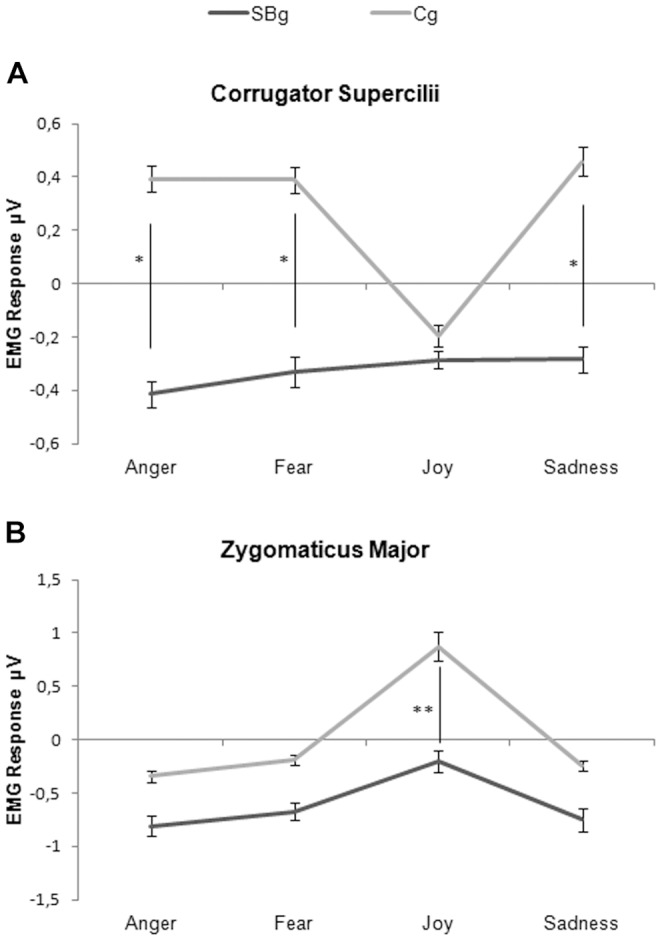
EMG responses.Corrugator Supercilii (A) and Zygomaticus Major (B) EMG responses for Street-Boys group (SBg) and Control group (Cg) during presentation of emotional facial expressions. * = p<0.05; ** = p<0.005. Only differences between groups were showed. See the text for differences inside each group. Error bars are SE.